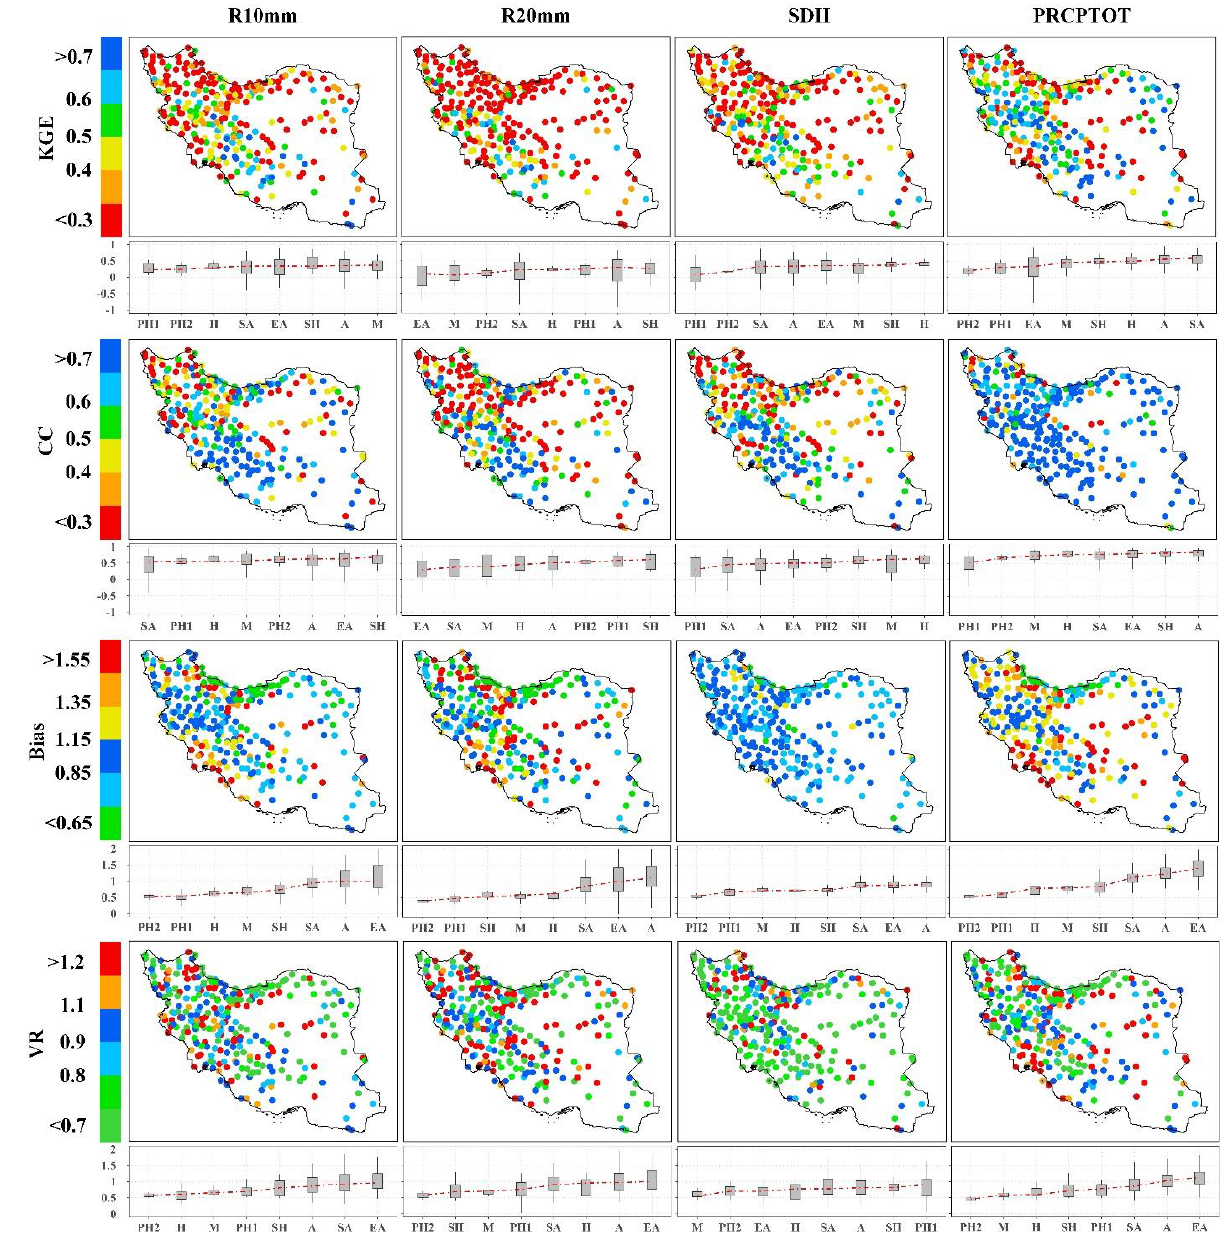
Figure 6. Reliability of GPM-IMERGV6.0 Final Run (GPM-IMERGF) in capturing absolute threshold precipitation indices based on bias, correlation coefficient (CC), variability ratio, and Kling-Gupta efficiency (KGE) error metrics.